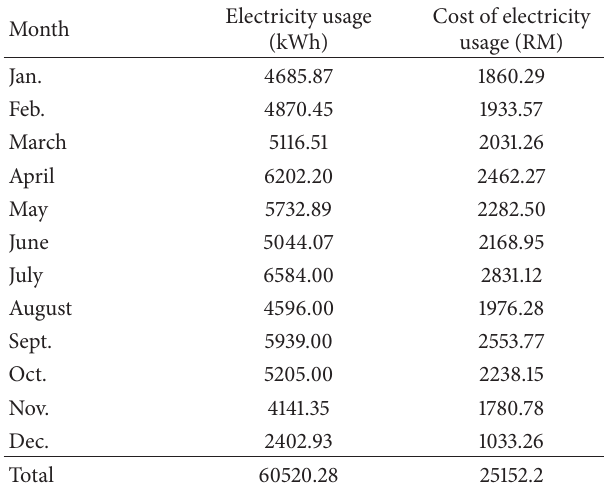
Table 1: Background information of the school.